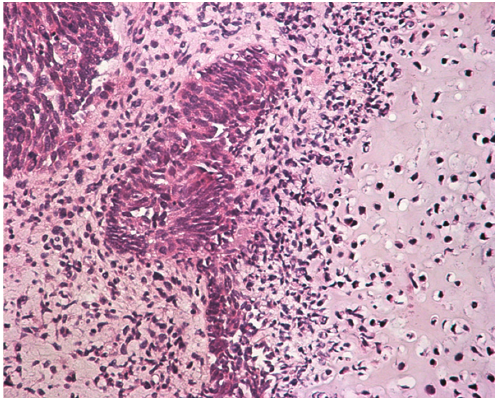
Figure 1: The epithelioid and sarcomatoid component of the tumor showing polygonal cells and spindle cells, respectively. There is focal appearance of osteosarcoma cells (hematoxylin-eosin, original magnification × 400).